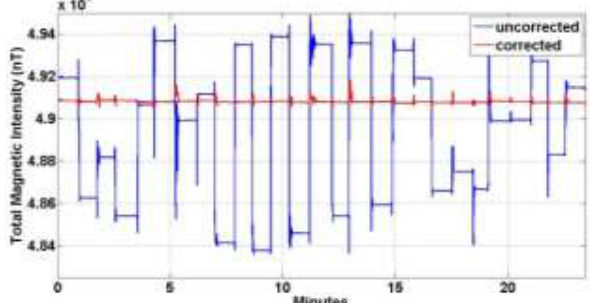
Figure7 Residual magnetic field